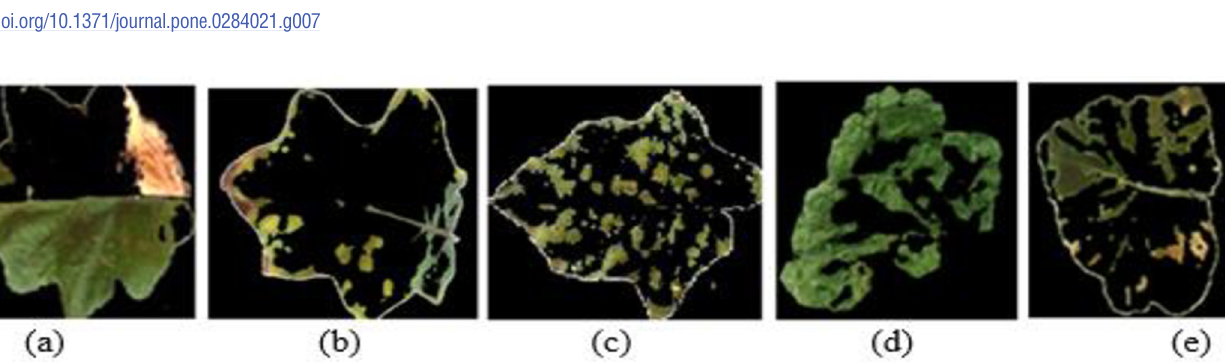
Fig 8. Image fusion based on Discrete Shearlet Transform (a) Pseudomonas solanacearum (b) Cercospora solani (c) Alternaria melongenea (d) Pythium aphanidermatum (e) Tobacco Mosaic Virus . https://doi.org/10.1371/journal.pone.0284021.g008 Table 3. PSNR and SSIM for leaf image.